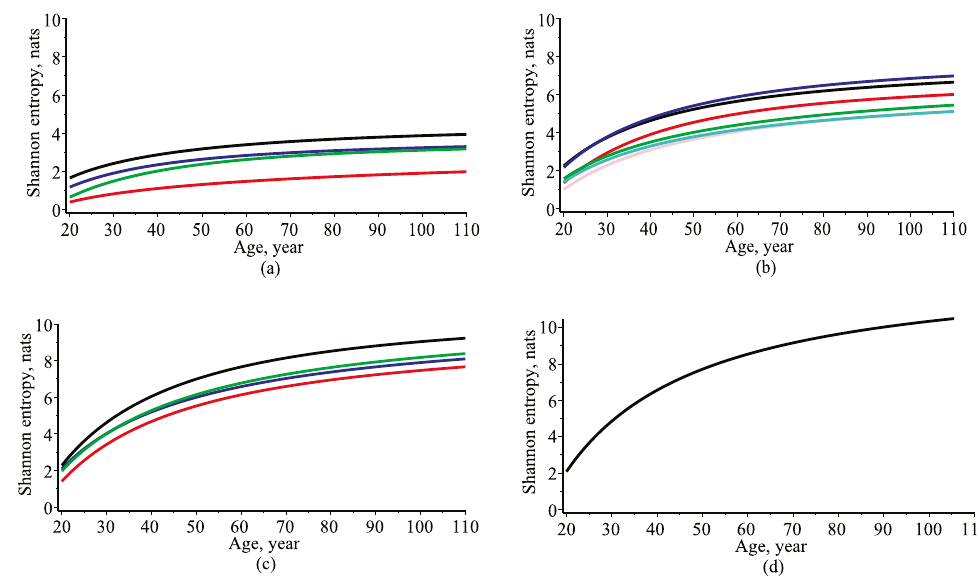
Figure 2. Evolution of the Shannon entropy. ( a ) Univariate: black—diameter; blue—height; green—crown base height; red—crown width. ( b ) Bivariate: black—diameter and height; blue—diameter and crown base height; green—diameter and crown width; red—height and crown base height; cyan—height and crown width; pink—crown base height and crown width. ( c ) Trivariate: black—diameter, height and crown base height; blue—diameter, height and crown width; green—diameter, crown base height and crown width; red—height, crown base height and crown width. ( d ) 4-variate: diameter, height, crown base height and crown width.